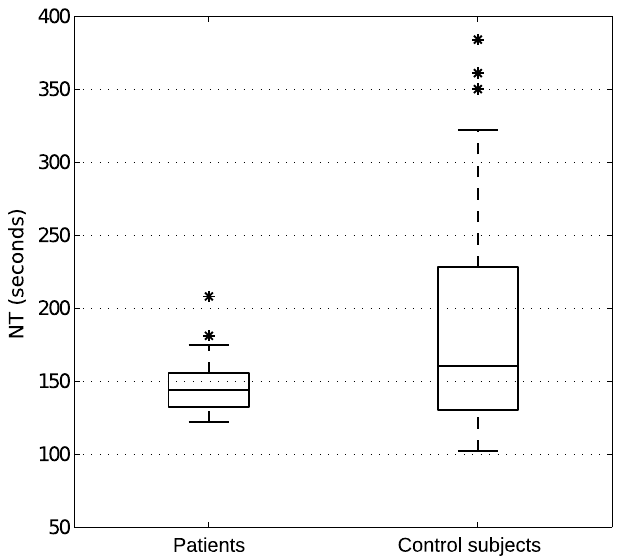
Figure 5. Box plot that summarises the four trials performed by each subject. A total of 19 patients’ timings and 62 control subjects’ timings is represented. Atypical cases, marked with asterisk, are